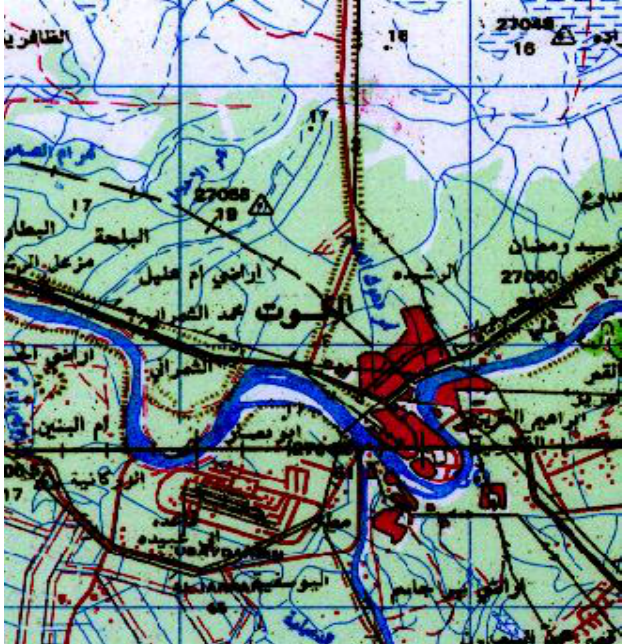
Fig. 2: The map with 1:250,000 for Al Kut city Wast province in Iraq.